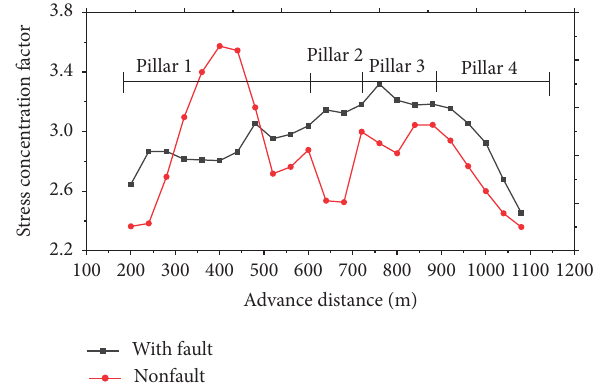
Figure 15: The stress concentration factor curves with setting or not setting